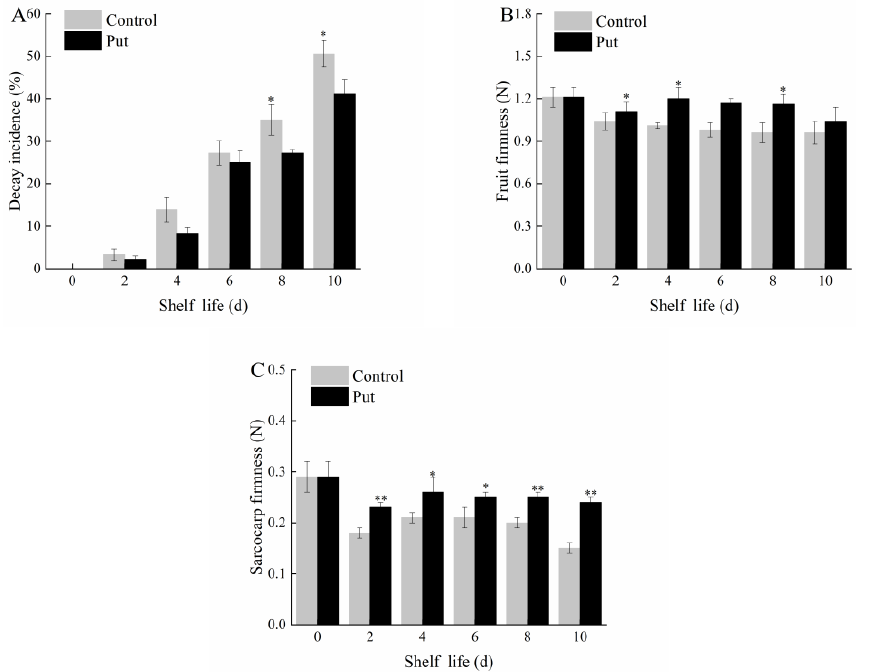
Figure 2. Changes in decay incidence ( A ), fruit firmness ( B ), and sarcocarp firmness ( C ) of posthar- vest blueberry fruit at 20 °C. Mean ± SE of three replicate experiments are shown. Asterisks indicate significant differences between control and Put − treated fruit (* p < 0.05, ** p < 0.01). The control was soaked in distilled water for 10 min, the same below.